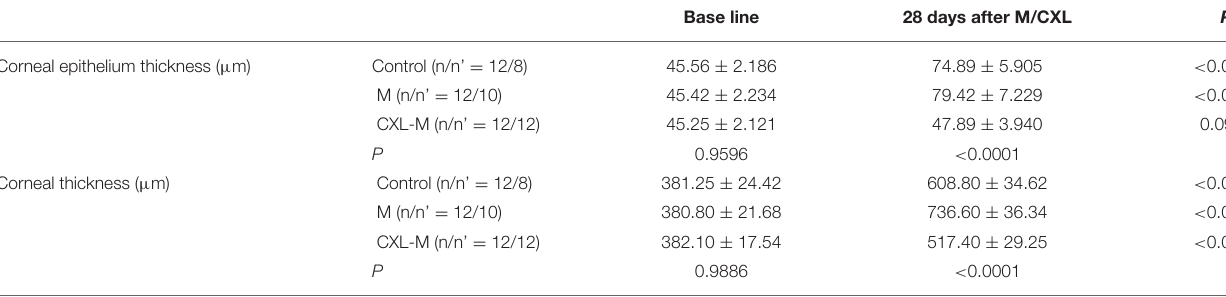
TABLE 1 | Corneal and corneal epithelium thickness in three groups.